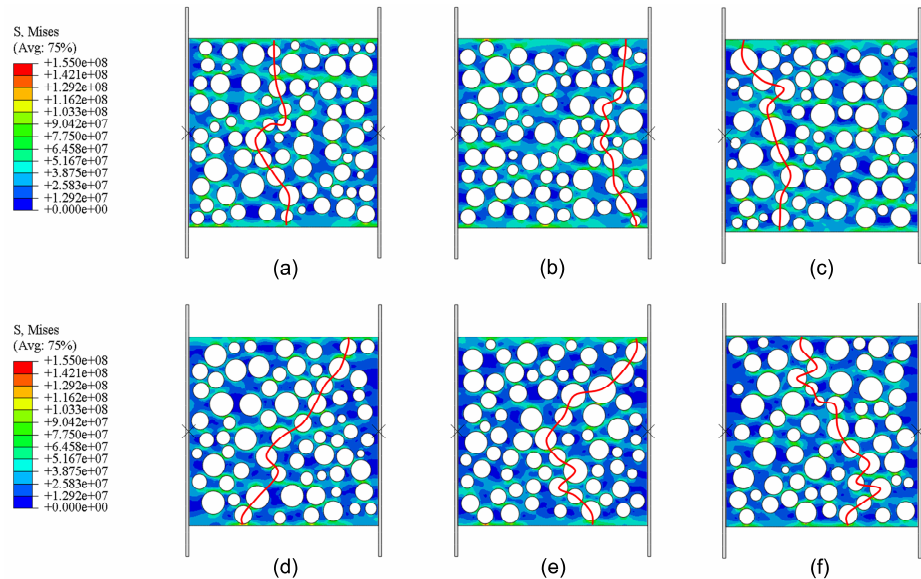
Figure 14. Stress clouds in the elastic region, ( a – c ) the structures with the highest elastic modulus, ( d – f ) the structures with the lowest elastic modulus.